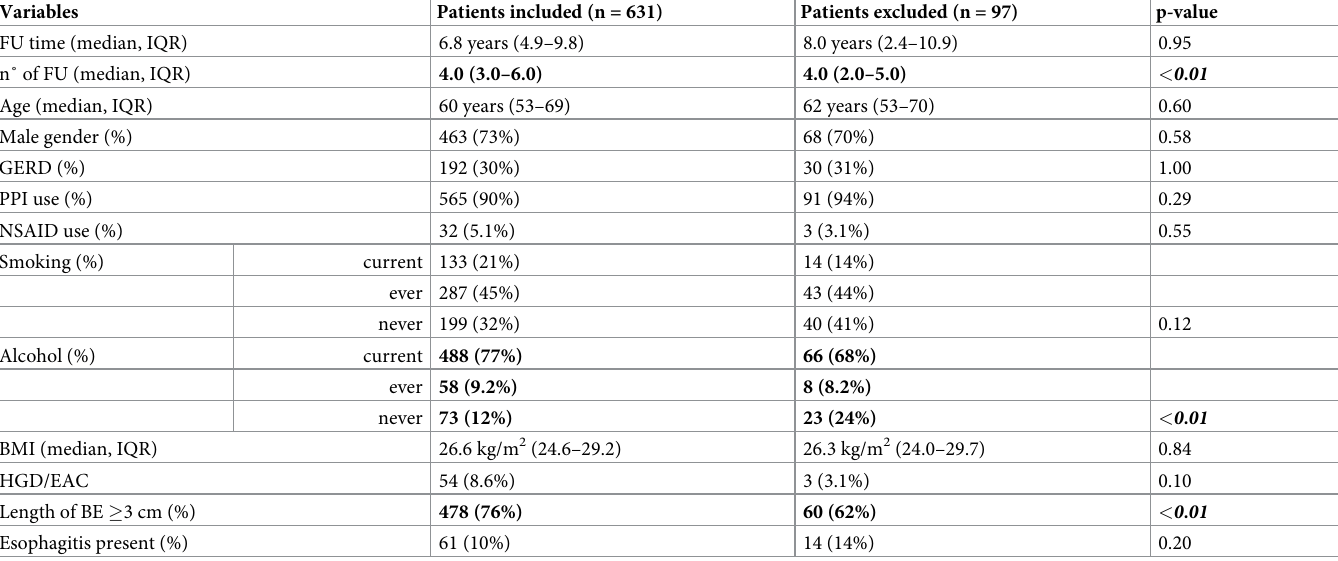
Table 1. Baseline characteristics.